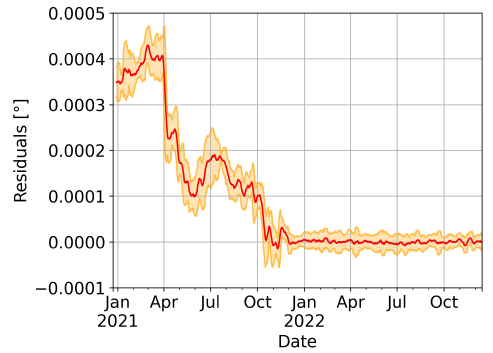
Figure 10. Iterative model: T1 residuals.